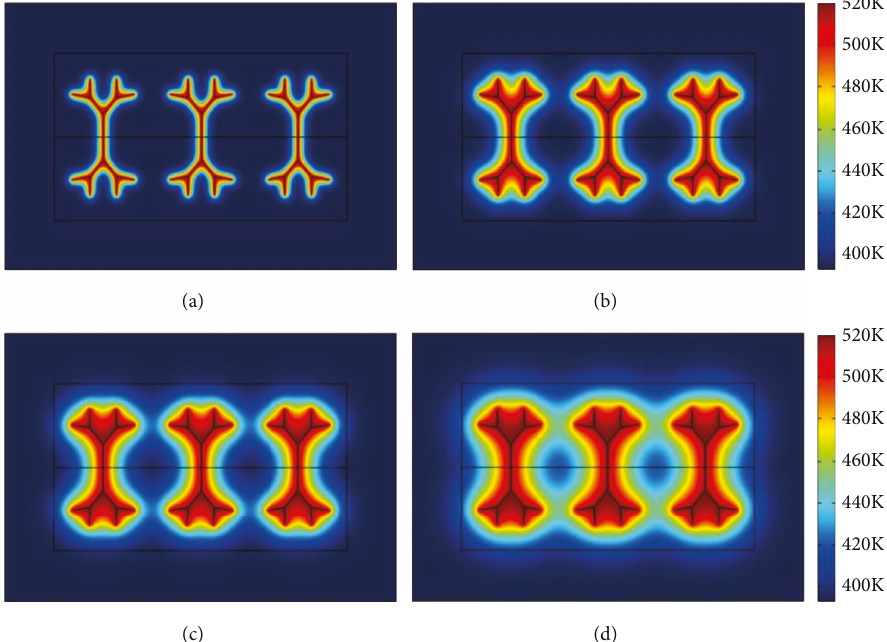
Figure 6: Distribution of temperature during the process of thermal stimulation (a) at 1 year, (b) at 5 years, (c) at 10 years, and (d) at 20 years.